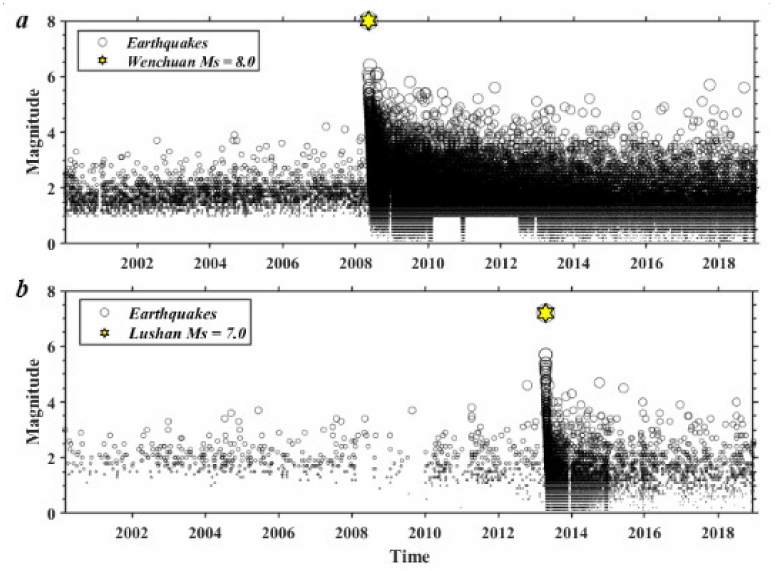
Figure 2. Magnitude versus time for events in the Longmenshan fault zone from 2000 to 2019. ( a ) Magnitude versus time for events in the M S 8.0 Wenchuan source region; ( b ) magnitude versus time for events in the M S 7.0 Lushan source